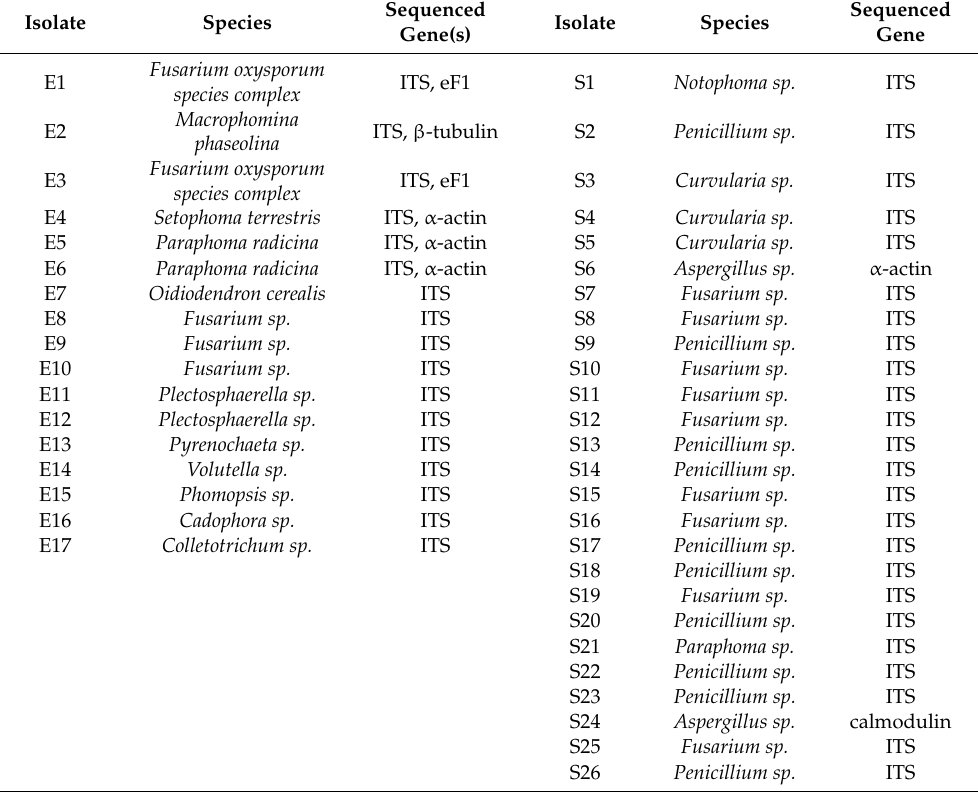
Table 1. List of identified horseradish root endophytes and soil fungi used in the study.